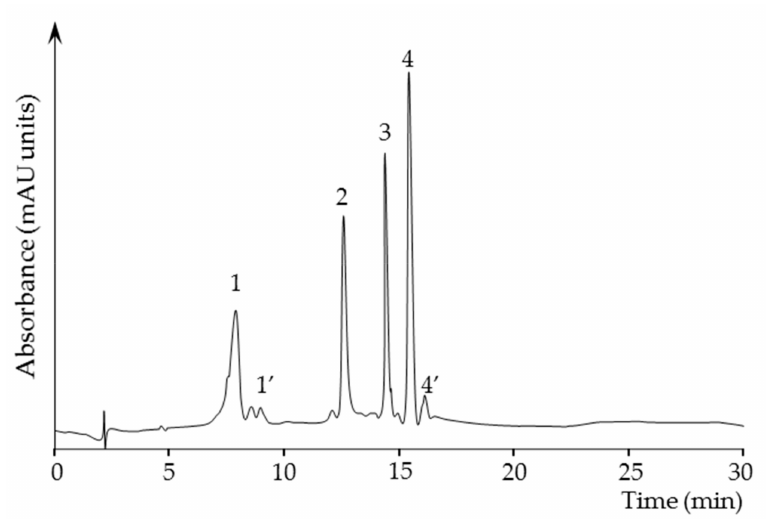
Figure 2. HPLC trace at 450 nm of the carotenoids extracted from the micellar fraction of a human mature milk sample digested in vitro. Carotenoid identification is as follows: 1, zeaxanthin + lutein;